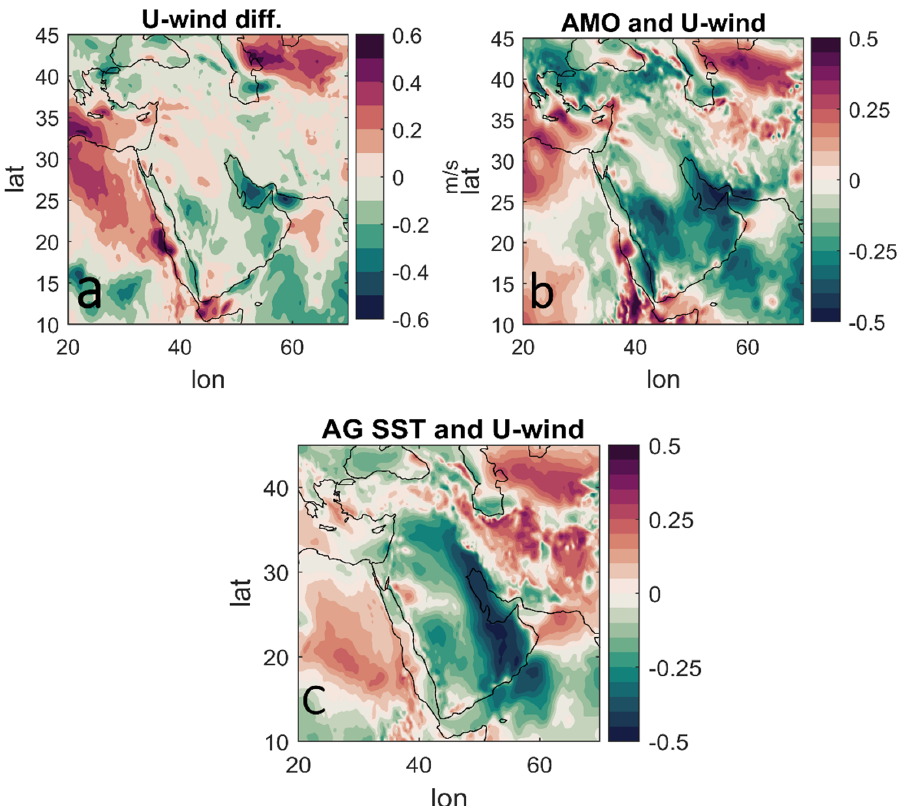
Figure 7. The difference in the U-wind component between pre- and post-1996 ( a ), correlation analysis between the AMO time series and U-wind ( b ), and correlation analysis between the AGs SST time series and U-wind ( c ). All the data are from 1971–2021.